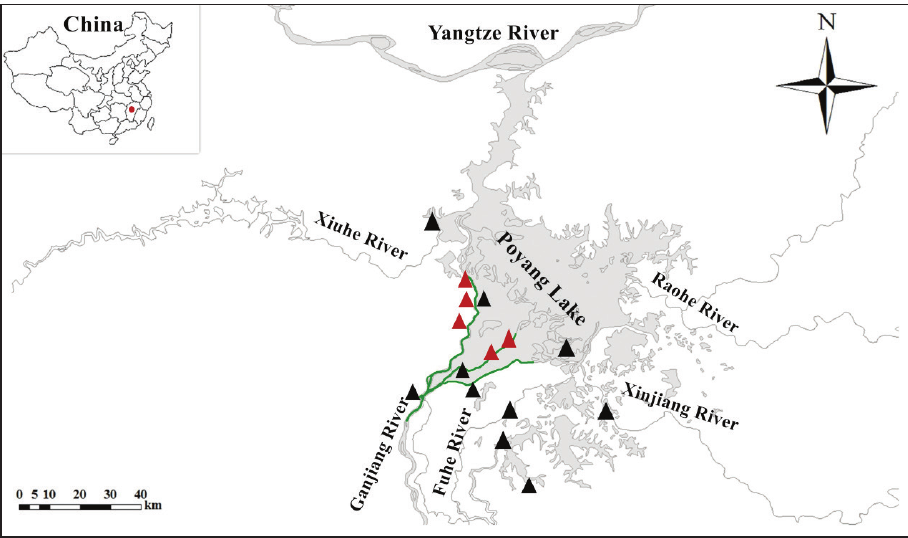
Figure 3. The distribution of S. carinata (Red triangle: In the study; Black triangle: Historical research; Green line: In the survey area; Historical data sources: Liu and Wu. 1991; Wu et al. 1994; Wu et al. 2000b; Liu et al. 2008; Xiong et al. 2011; Xiao et al. 2012; Zhang et al. 2013; Huang et al. 2013).